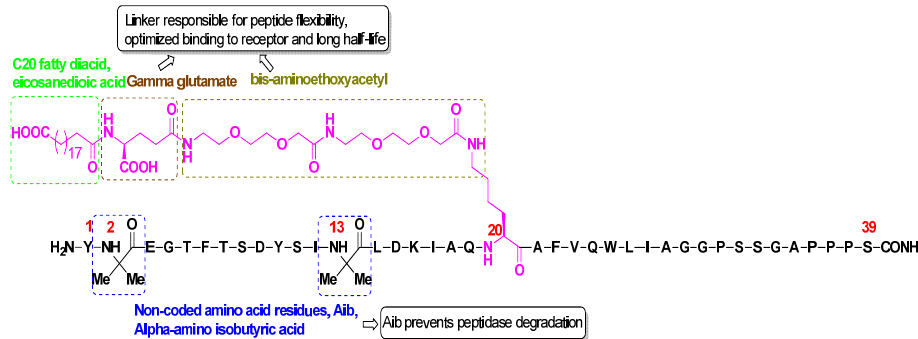
Figure 2. Structural features of tirzepatide, amino acids are denoted as single ‐ letter